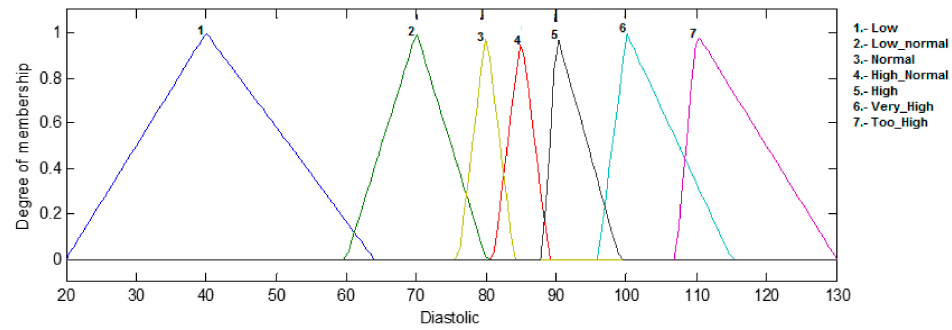
Figure 18. Diastolic input for the fuzzy logic classifier 4.